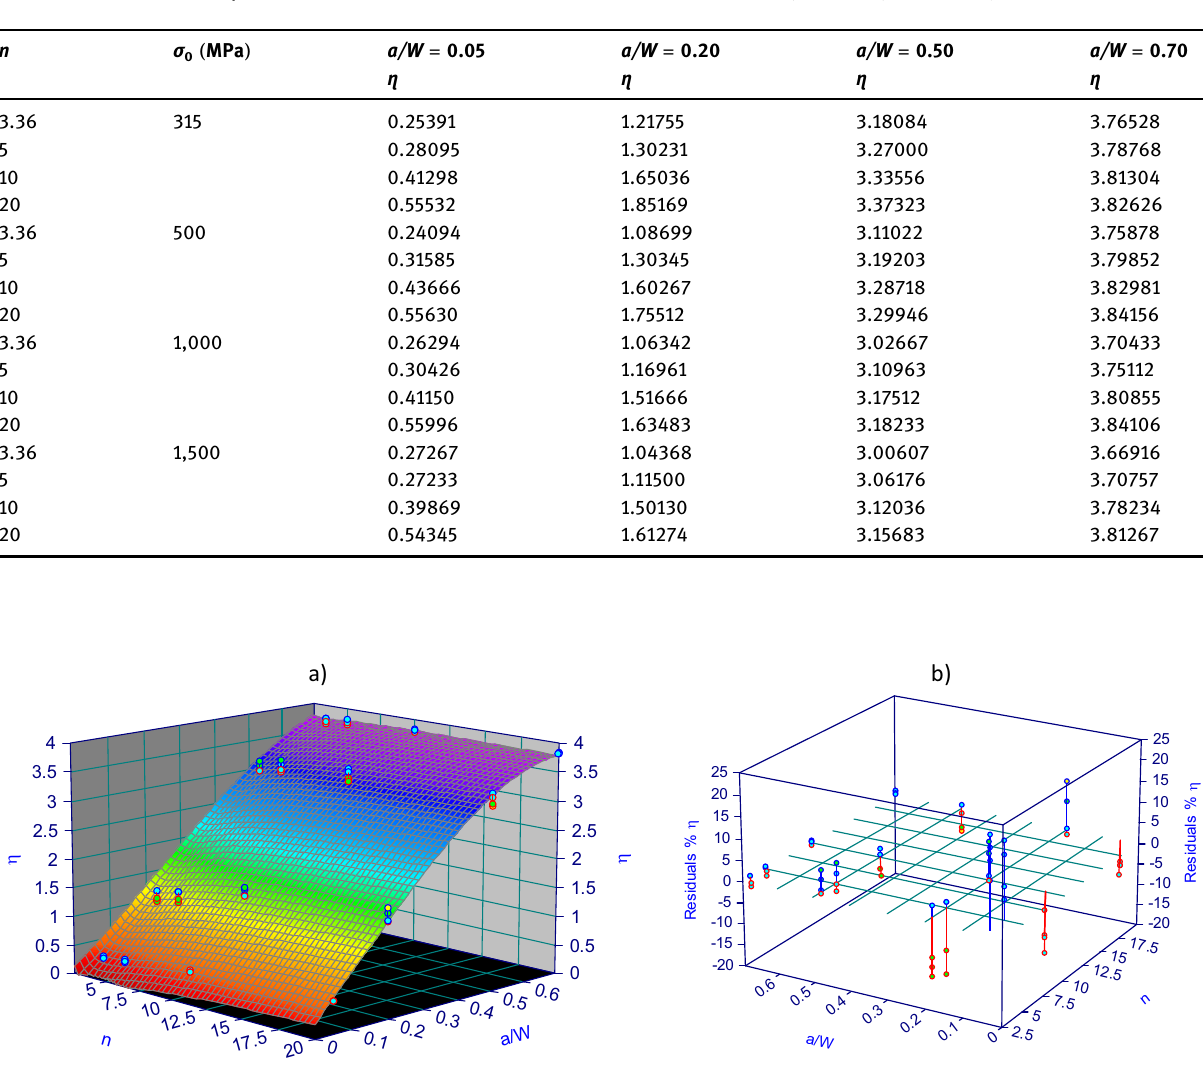
Table 8: The values of the η coe ffi cients estimated based on numerical calculation and analytical analysis using equations ( 2 ) and ( 21 – 25 )